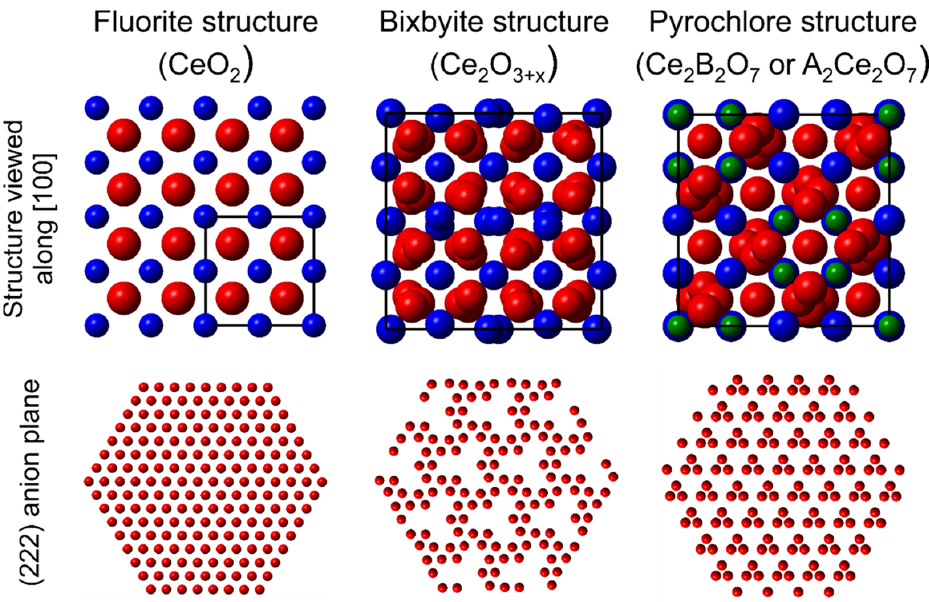
Figure 10. Ce-bearing oxides with fluorite, bixbyite, and pyrochlore structures viewed along the (100) direction ( top ) and the corresponding (222) plane anion layers ( bottom ). Blue and green spheres represent cations, while red spheres represent oxygen anions. Unit cells are delineated with black lines. The bixbyite structure can be characterized as a fluorite-derivative with 1/8 of the anions replaced by constitutional vacancies, while the pyrochlore structure is a fluorite-derivative with ordering of two cation species and ¼ of the anions replaced by constitutional vacancies.